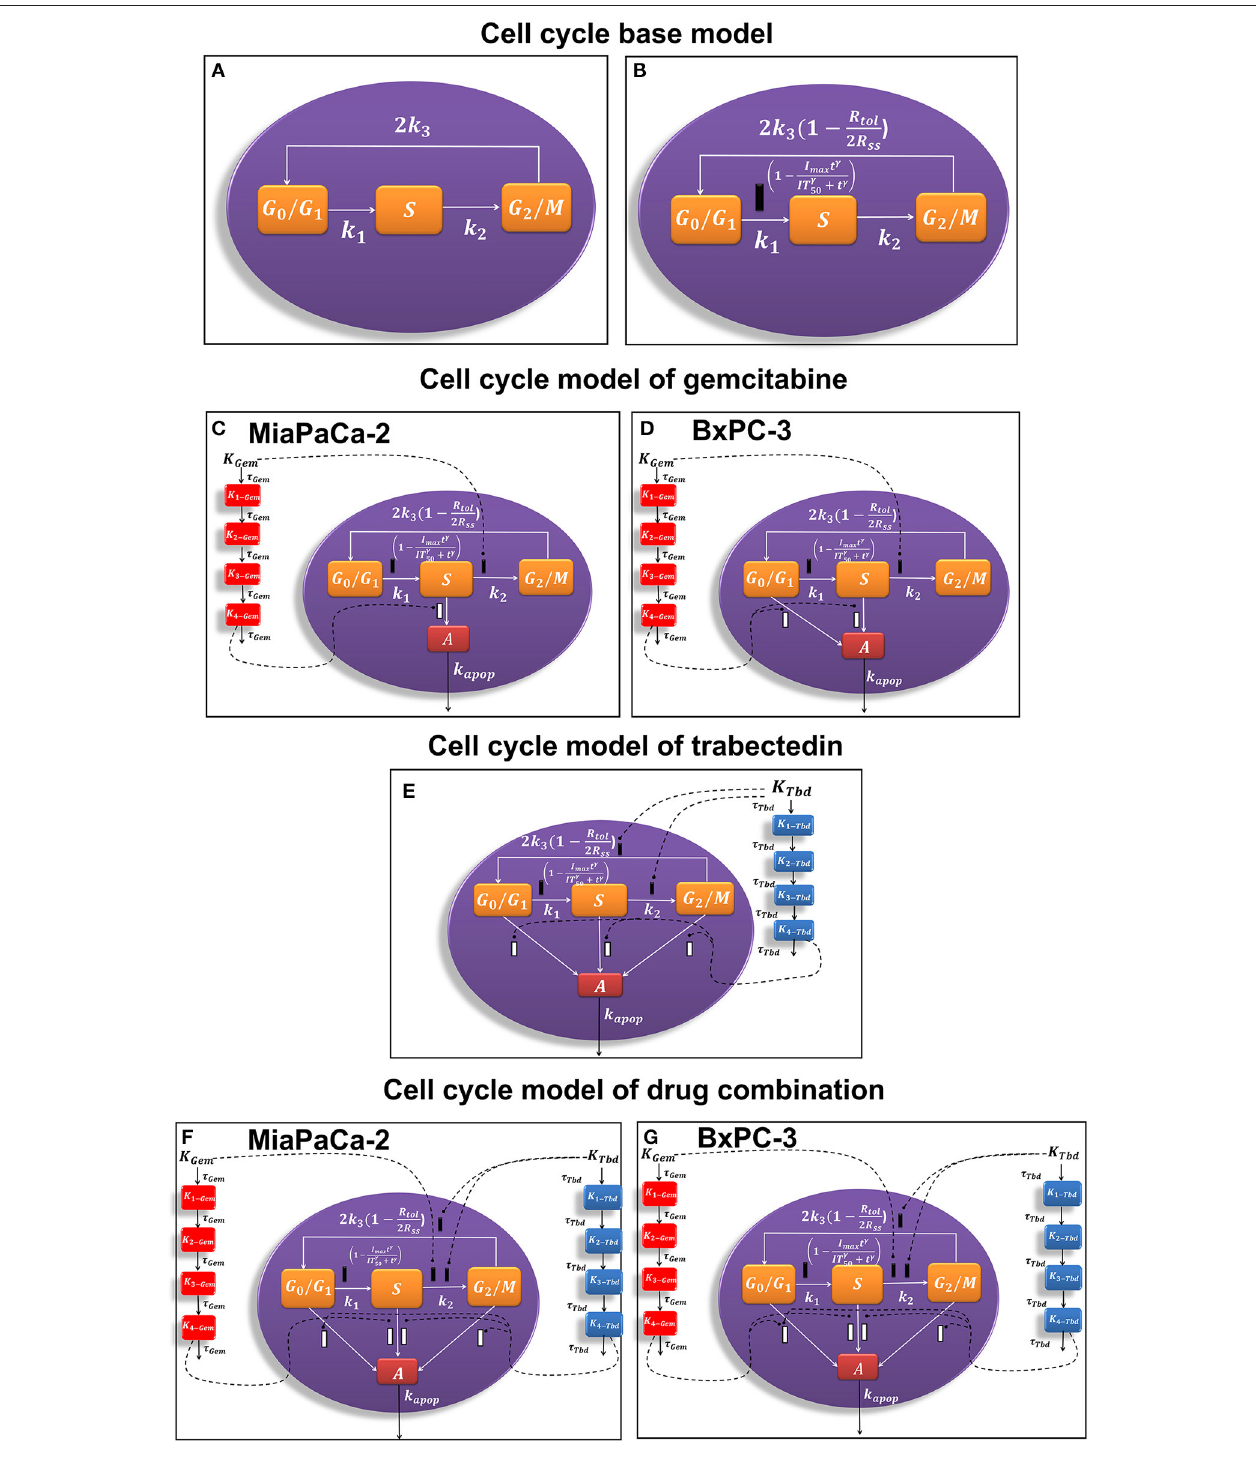
FIGURE 1 | Schematic of the pharmacodynamic models for single and combination drug effects on the cell cycle. (A) Cell cycle base model. (B) Alternative cell cycle base model. (C) Cell cycle model of gemcitabine for MiaPaCa-2 cells. (D) Cell cycle model of gemcitabine for BxPC-3 cells. (E) Cell cycle model of trabectedin for MiaPaCa-2 and BxPC-3 cells. (F) Cell cycle model of drug combination for MiaPaCa-2 cells. (G) Cell cycle model of drug combination for BxPC-3 cells.